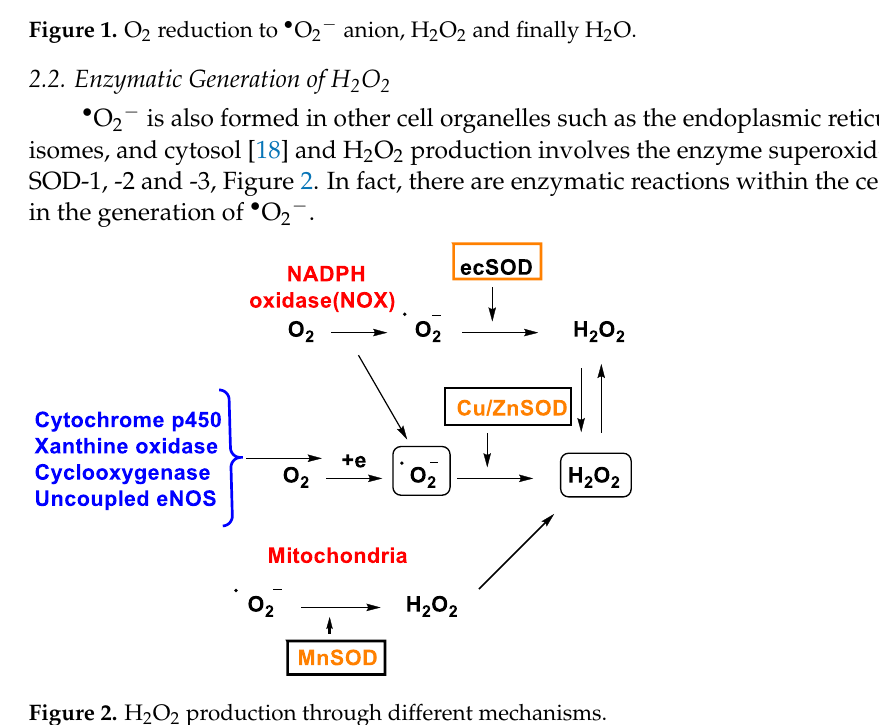
Figure 1. O 2 reduction to • O 2 − anion, H 2 O 2 and finally H 2 O.